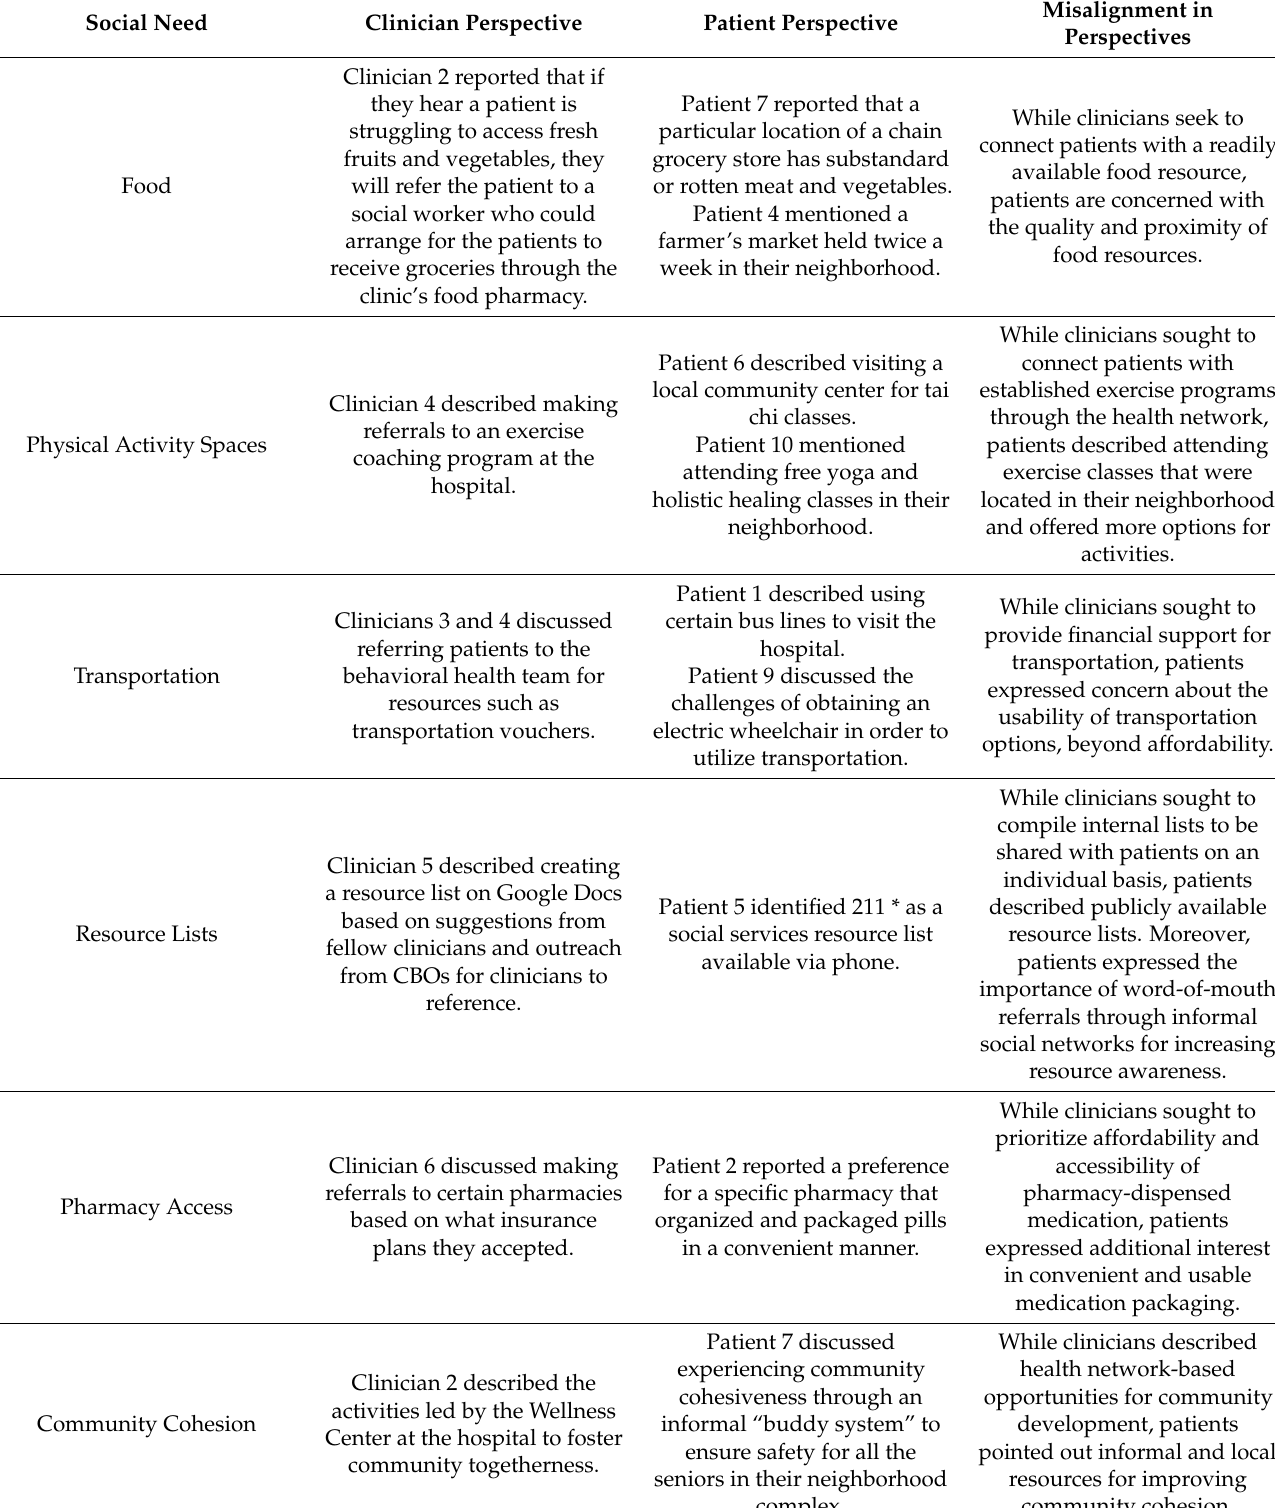
Table 2. Comparisons of Provider and Patient Perspectives on Social